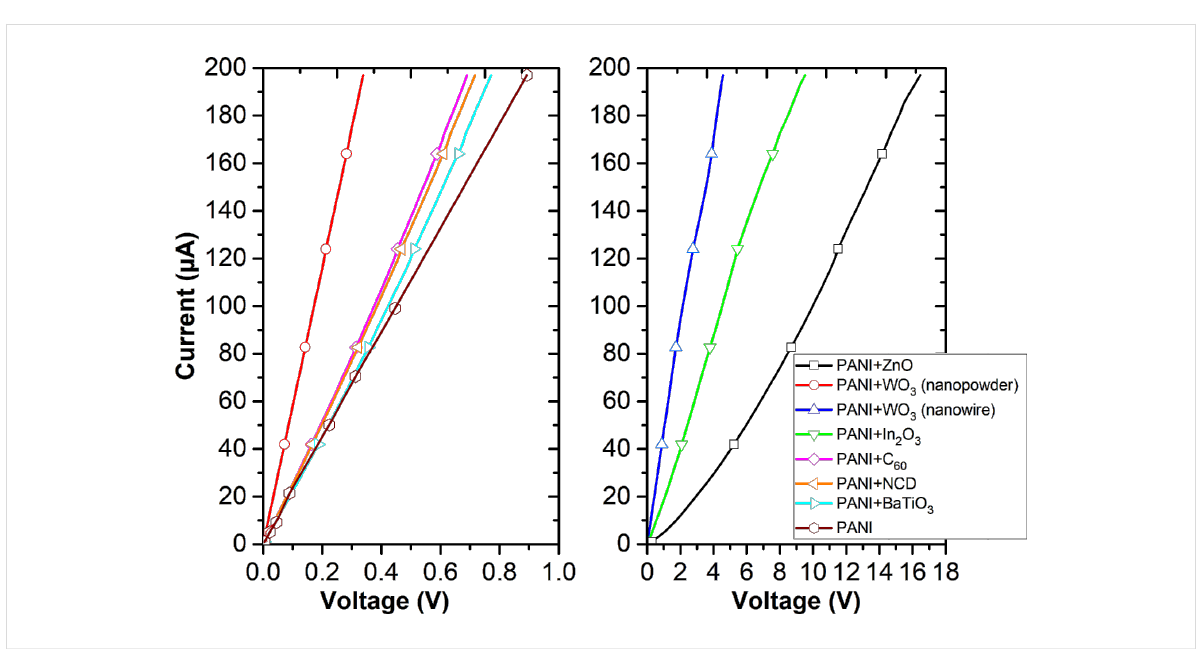
Figure 3: Current–voltage characteristics of active layers.